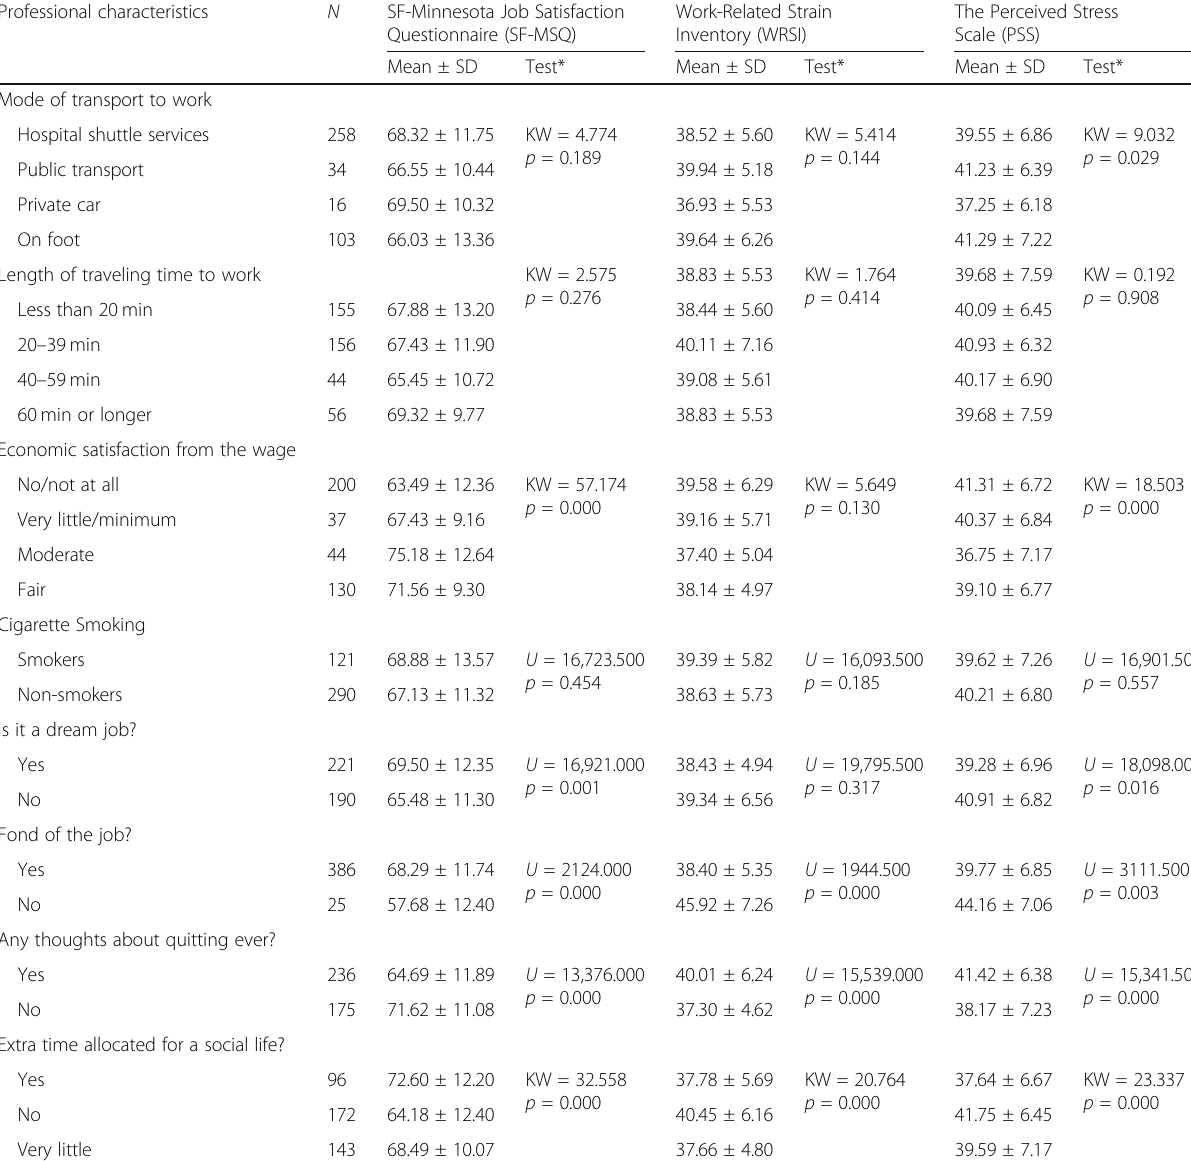
Table 7 Mean scores of SF-MSQ, WRSI, and PSS by the selected psychosocial characteristics of nurses ( N = 411)